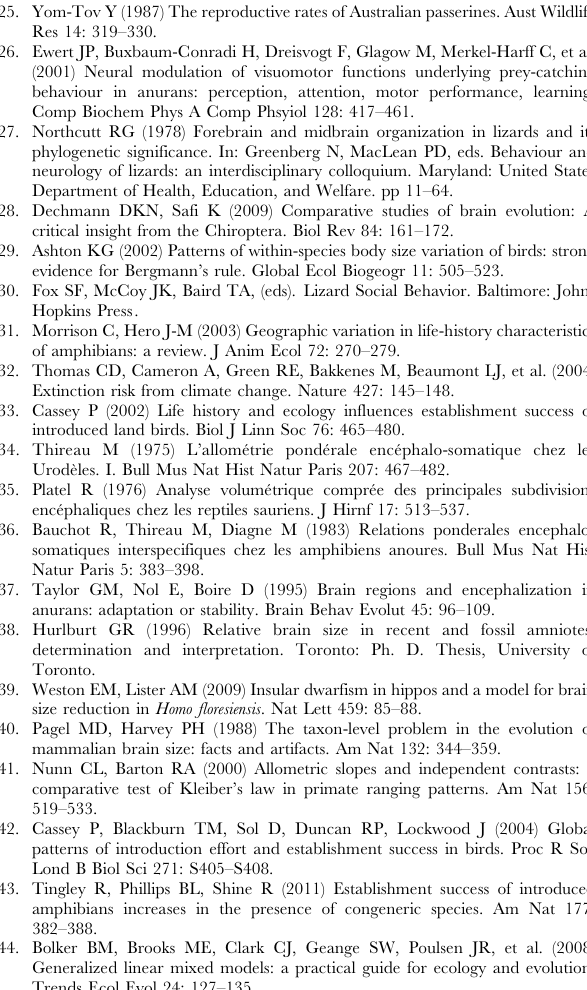
Figure S1 95% prediction intervals on the conditional modes of the random intercepts and slopes of the relationship between residual brain mass and estab- lishment probability in amphibian and reptile species.